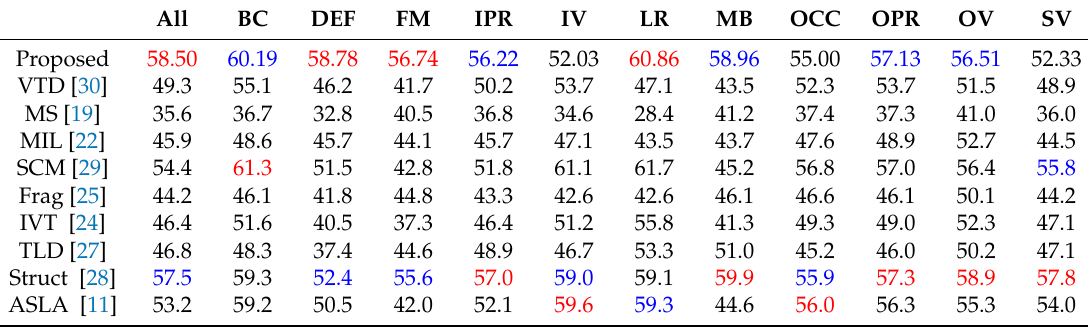
Table 2. Average of overlap score of the proposed tracker and several current state of the art trackers ((BC), deformation (DEF), fast motion (FM), in-plane rotation (IPR), illumination variation (IV), low resolution (LR), motion blur (MB), occlusion (OCC), out-of-plane rotation (OPR), out-of view (OV) and scale variation (SV)). The top two methods for each dataset are highlighted in red and blue, respectively. VTD, visual tracking decomposition; MS, mean-shift; MIL, multiple instance learning; SCM, sparse collaborative appearance; Frag, fragment-based; TLD, tracking-learning-detection.